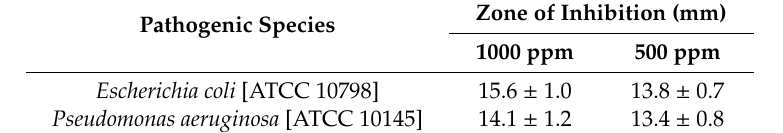
Figure 7. Zones of inhibition of ecofriendly synthesized AgNPs (30 μ L) at 500 and 1000 ppm concentrations in water against E. coli and P. aeruginosa.